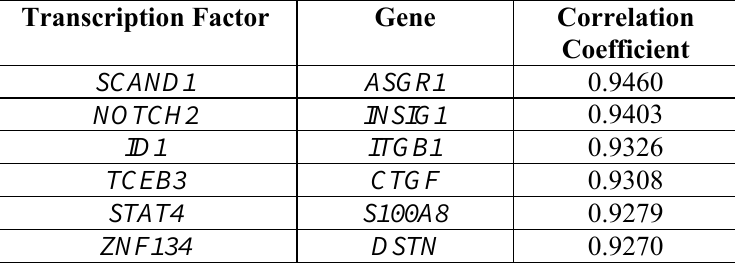
Table 1: List of top ten highly correlated (both positively and negatively) human genes with corresponding transcription factors (here, α =